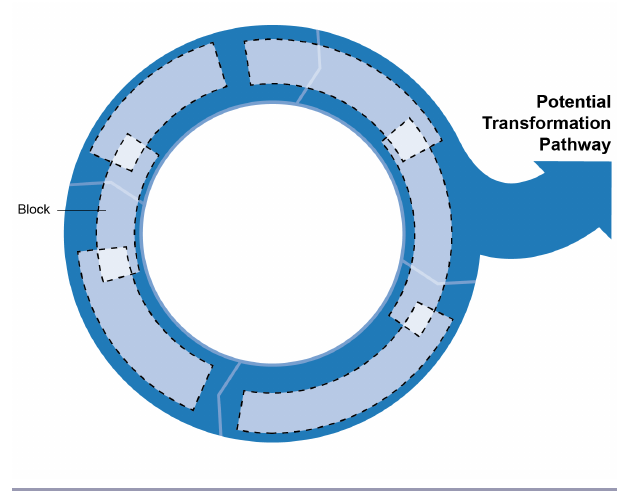
Fig. 1 . Building blocks along a transformation pathway. This graphic representation emphasizes that it is more important to think about how building blocks may fit together rather than assuming a linear pathway. Several blocks together begin to build a